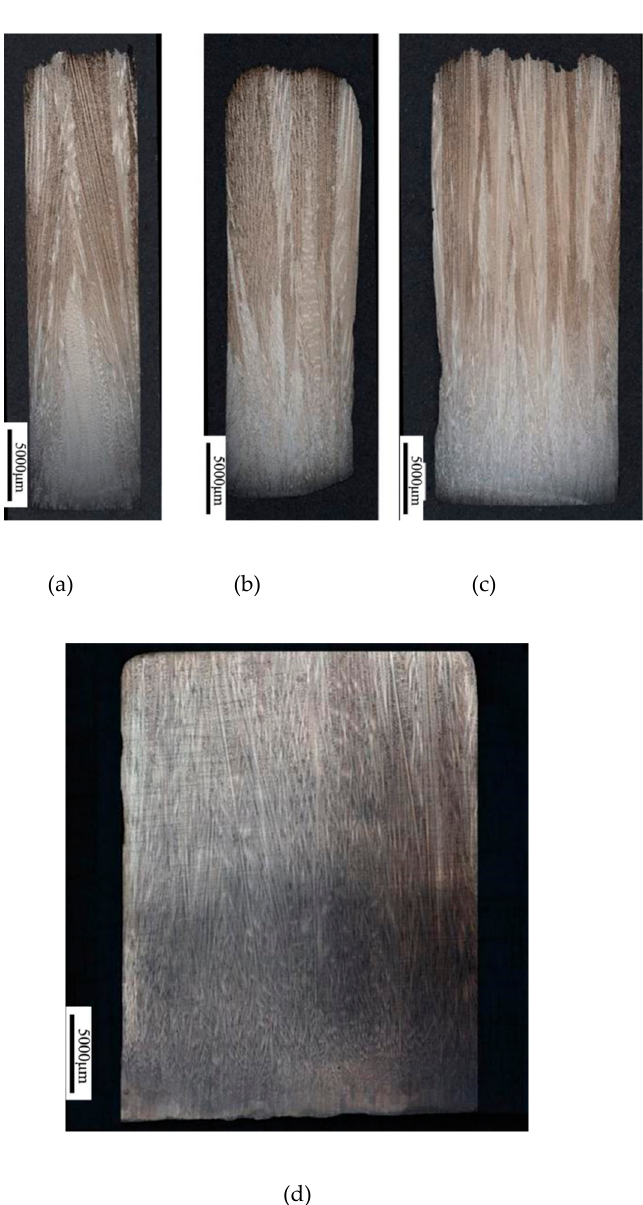
Figure 3. Metallographic photos of longitudinal sections of starters with different widths: ( a ) 8 mm, ( b ) 10 mm, ( c ) 15 mm, and ( d ) 30 mm.